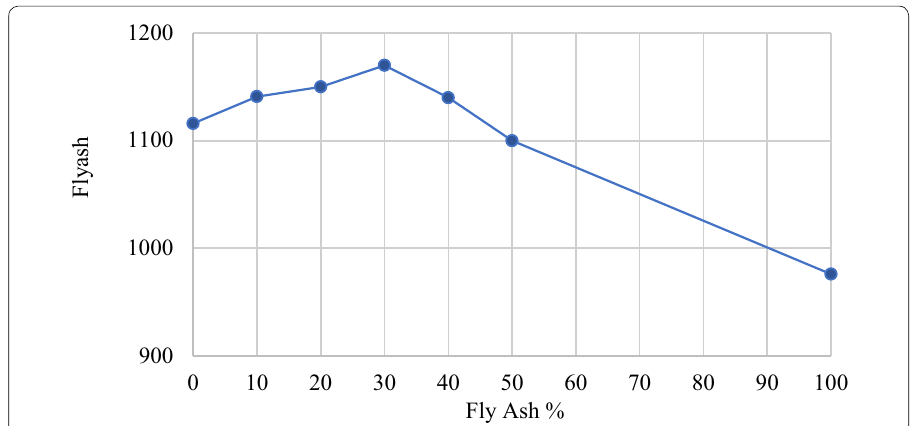
Fig. 4 Variation of maximum dry density with Flyash content